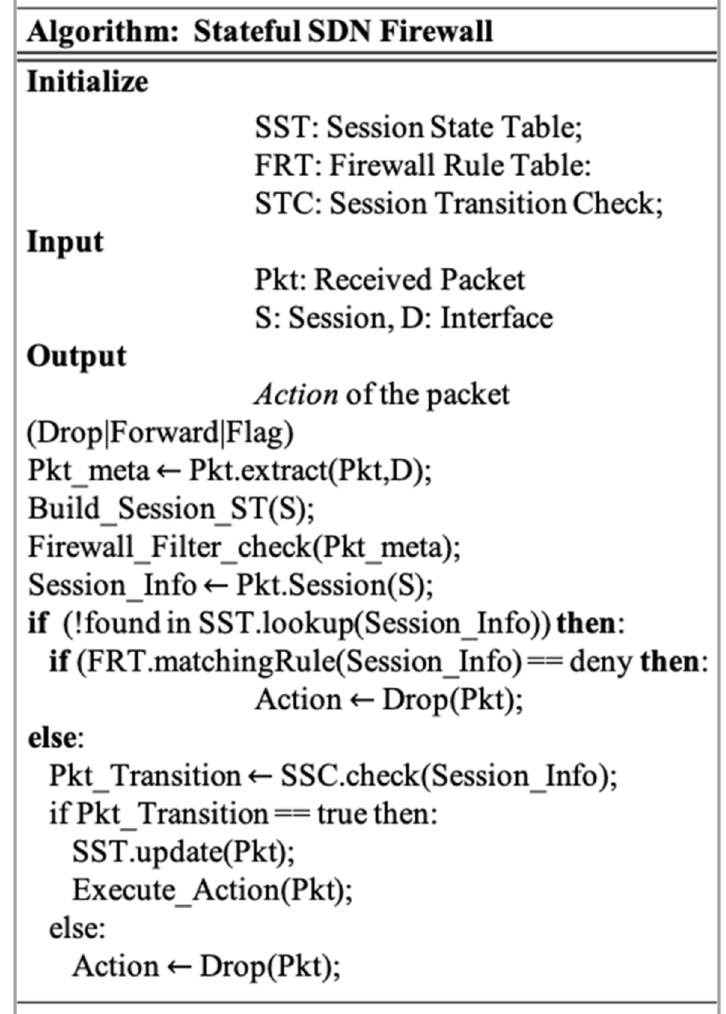
Fig. 8 Stateful Firewall in SDN-OpenStack